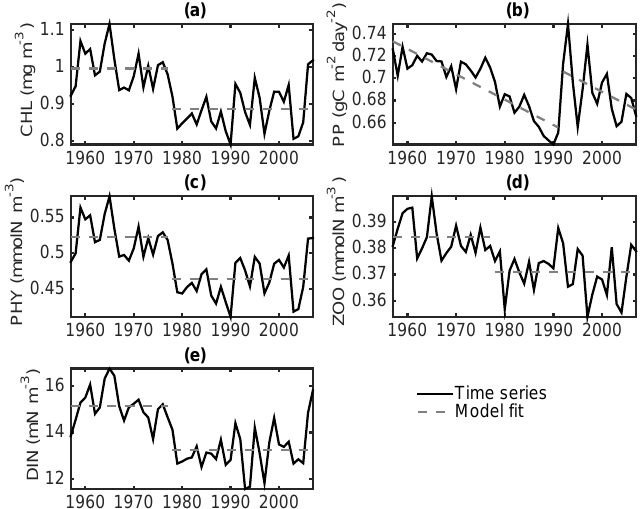
Figure B1. Time series of (a) surface chlorophyll, (b) integrated primary production, (c) total surface phytoplankton, (d) zooplankton biomass and (e) surface dissolved inorganic nitrogen simulated with the HadOCC model and averaged over the Gulf of Alaska region. The dotted lines represent the statistical model